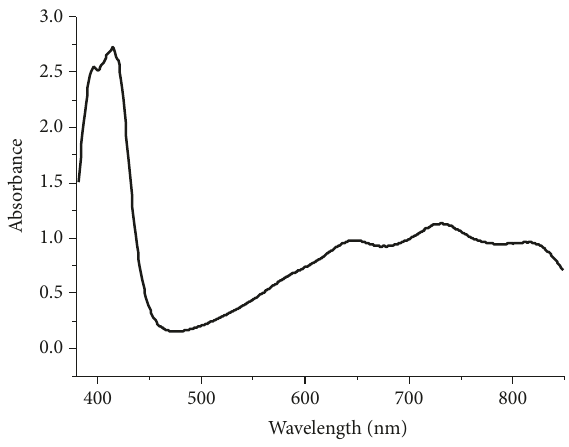
Figure 9: UV-Vis absorption spectrum of ABTS + H 2 O 2 + 2 , recorded 10min after mixing the